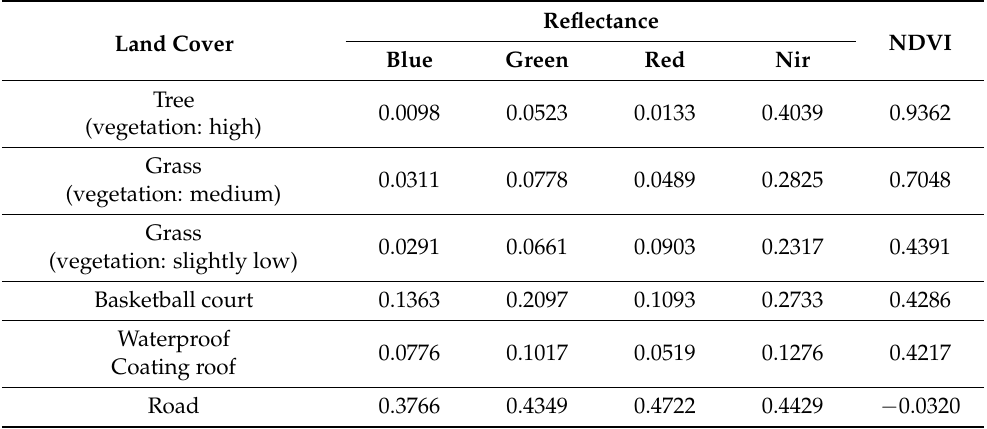
Table 7. Reflectance by bands (R, G, B and Nir) and NDVI for each land cover using ASD Field- Spec4 spectrometer.